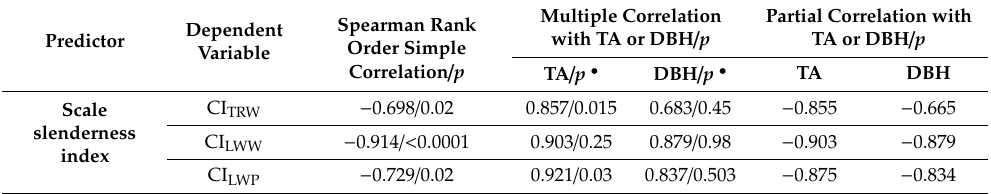
Table 4. Bark as predictor of spruce wood structure from the breast height (only the correlations with R > 0.5 are shown).